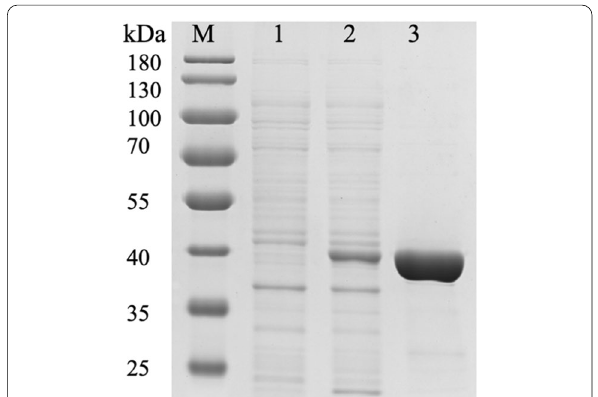
Fig. 5 SDS-PAGE analysis of DnFPPS recombinant protein. M: protein standard marker (180 kDa); 1: The culture supernatant (negative control) from mock transformant E. coli BL21(DE3) containing expression vector pET-28a; 2: culture supernatant culture supernatant (positive control) from transformant E. coli BL21(DE3) containing expression vector pET-28a-DnFPPS; 3: purified DnFPPS